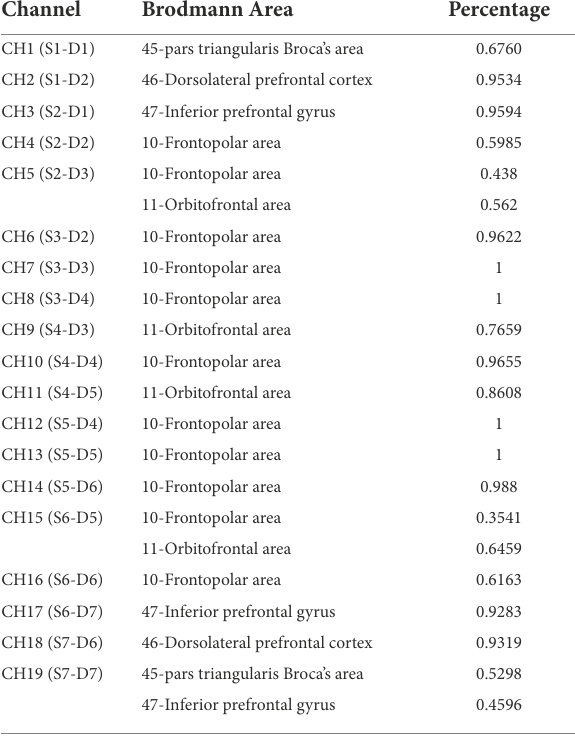
TABLE 1 Percentage of main cerebral regions corresponding to each